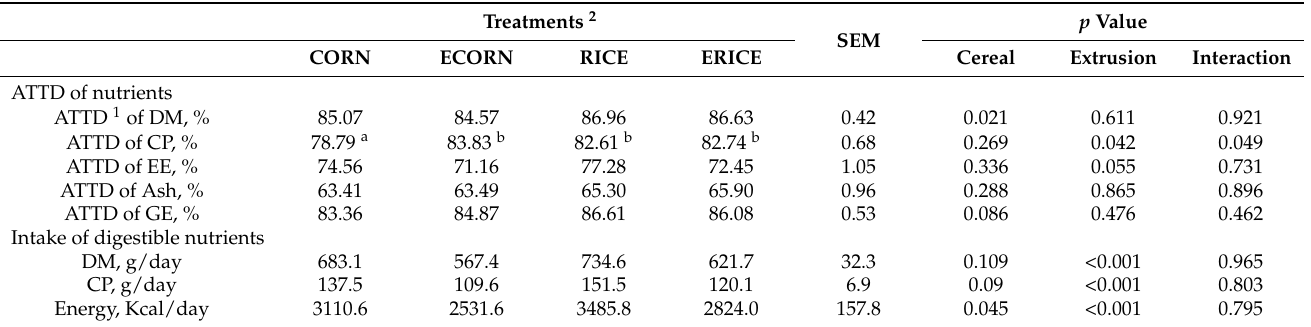
Table 4. Effects of cereal types and extrusion processing on the nutrient apparent digestibility and